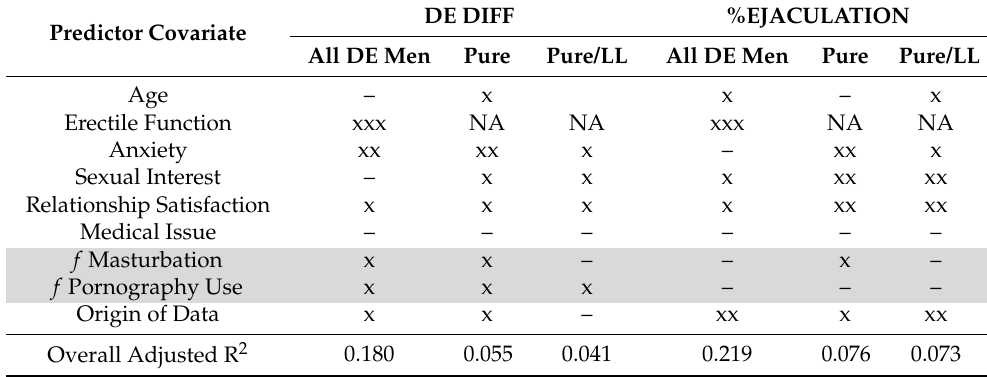
Table 5. Summary of variable effects showing consistency in patterns of predictor covariates in the overall sample, in the sample that included men with pure DE, and in the sample that included men with pure/lifelong (LL) DE 1 . Effects of frequency of masturbation and frequency of pornography use are grey-shaded for emphasis.